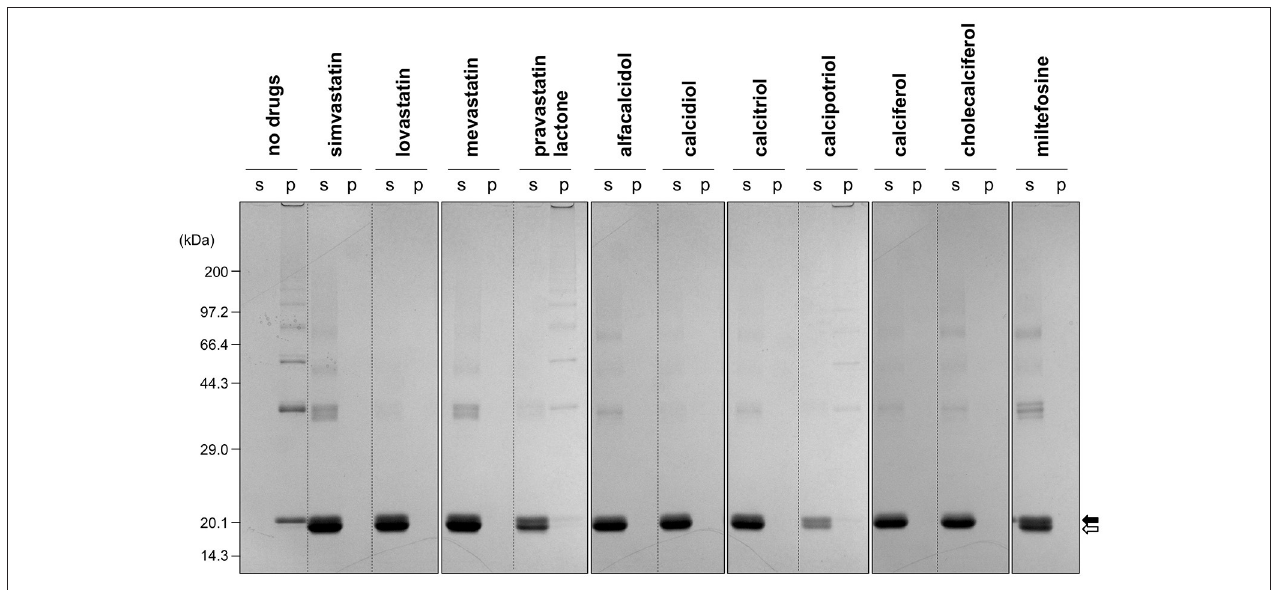
FIGURE 4 | Formation of insoluble SOD1 oligomers was efficiently suppressed by the hit compounds. As shown in Figures 2 , 3 , 20 µ M apo-SOD1(G37R) S - S was shaken at 37 ◦ C for 12h in the NNE buffer containing 1MGdn in the presence of the indicated drugs (20 µ g/mL) and then fractionated into